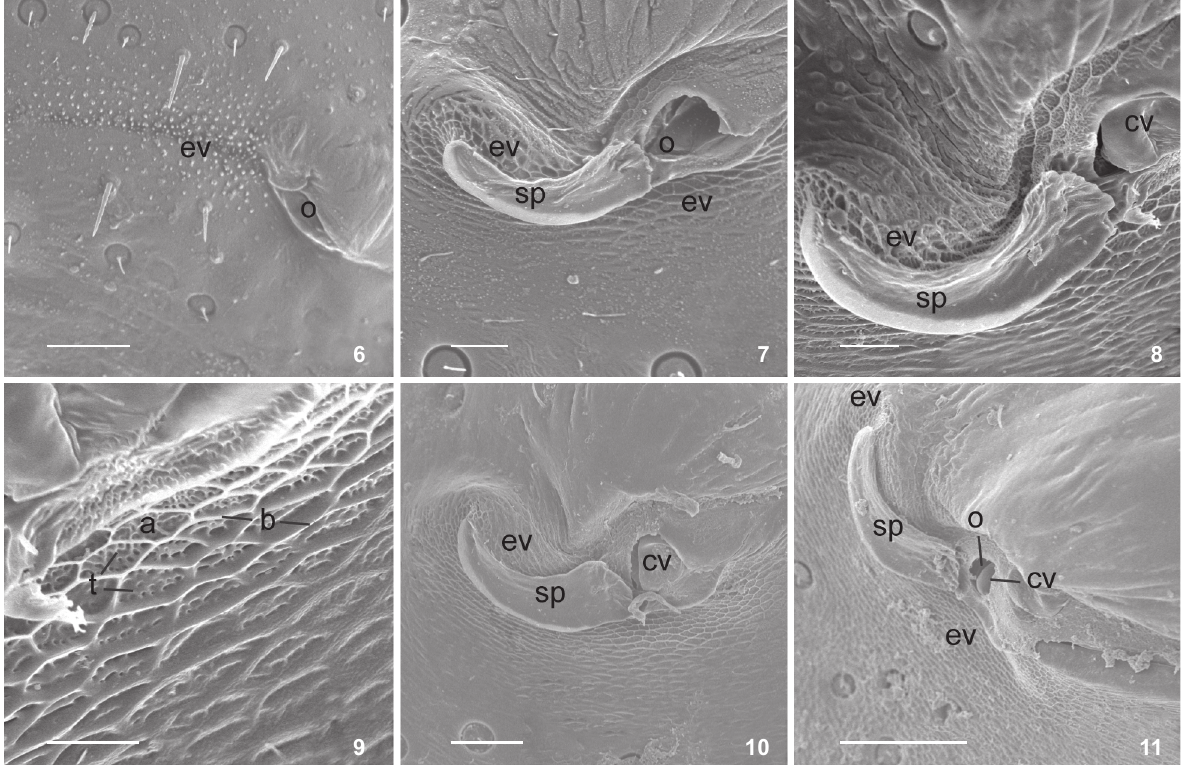
Figures 6-11. External cuticular structures of median dorsal abdominal gland of nymphs of Euschistus (Mitripus) grandis under scanning electron microscopy: (6) first instar; (7) second instar; (8) third instar; (9) magnification of evaporatorium, third instar; (10) fourth instar; (11) fifth instar. (a) Alveole, (b) bridges, (cv) cuticular valve, (ev) evaporatorium, (o) ostiole, (sp) spout peritreme, (t) trabeculae. Scale bars: 6, 10 = 50 µm, 7-8 = 20 µm, 9 = 10 µm, 11 = 100